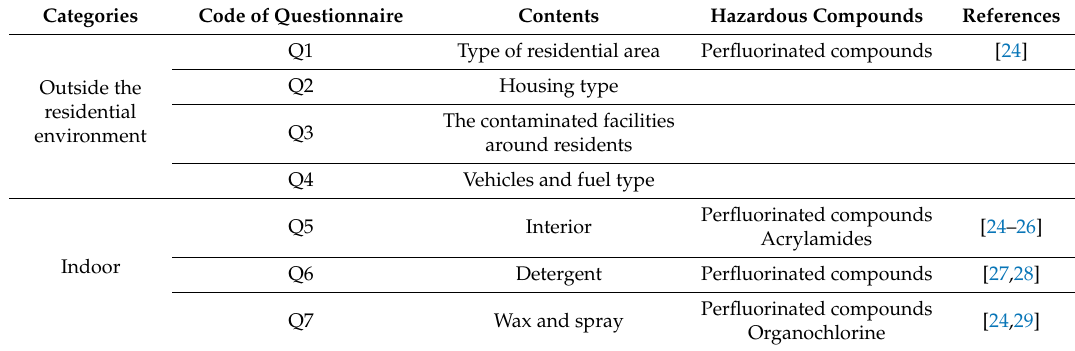
Table 3. Exposure assessment of hazardous compounds from the